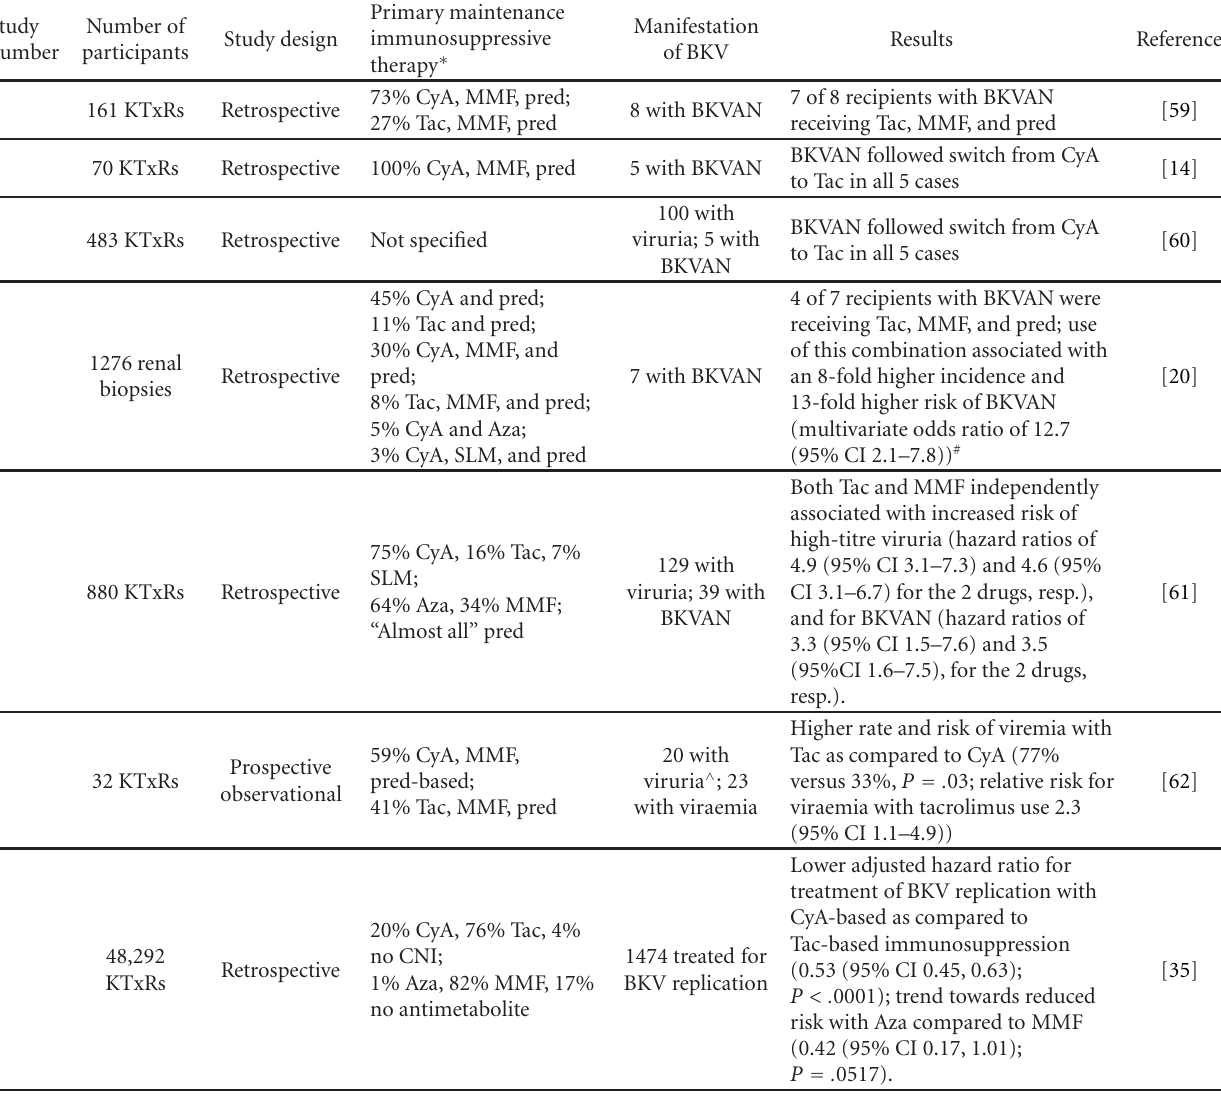
Table 2: Clinical studies examining the influence of the calcineurin inhibitors and antimetabolites on risk of BKV replication. Study